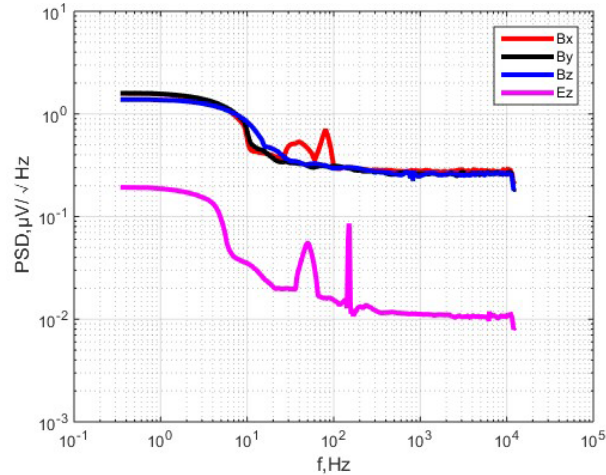
Figure 6. Noise power spectral density. The pink curve represents the electric field channel. The red, black, and blue curves represent the magnetic field channels B x , B y , and B z , respectively.